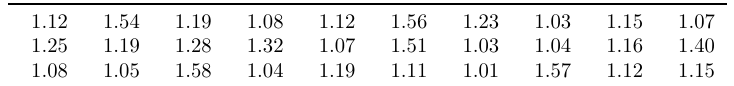
Annual wage data (in multiplies of 10 ; 000 U.S.